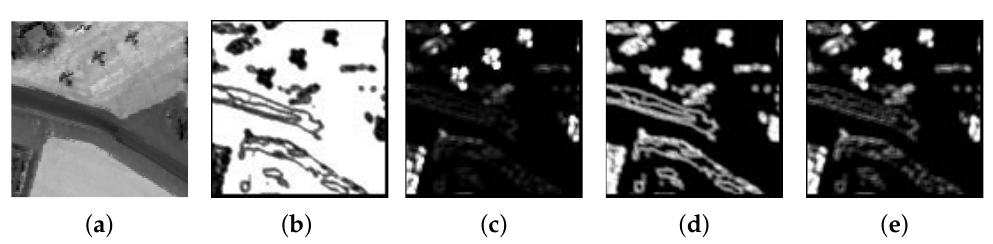
Figure 3. Extended feature maps F = [ f 0 , f 1 , f 2 , f 3 , f 4 ]. ( a ) f 0 : result map through de-noised graph Fourier transform (GFT); ( b ) f 1 : second moment; ( c ) f 2 : contrast; ( d ) f 3 : entropy; ( e ) f 4 :